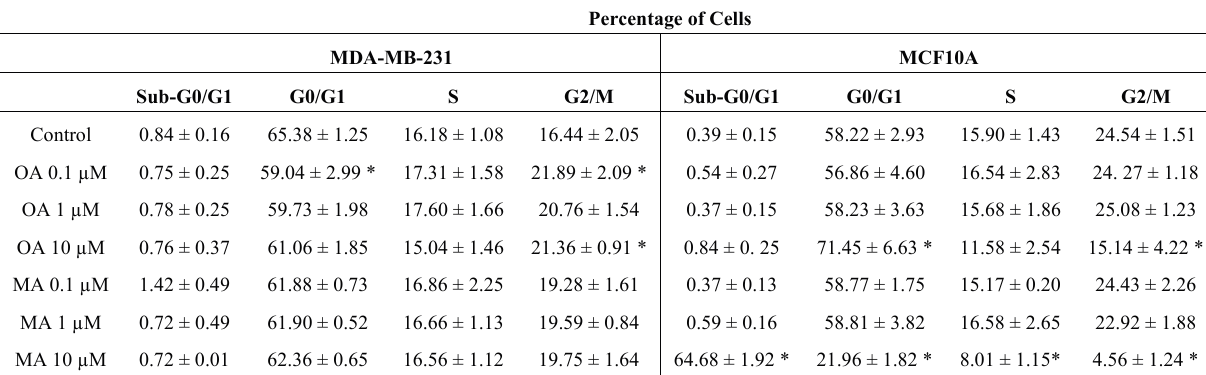
Table 1. Distribution of cells in phases of the cell cycle for MDA-MB-231 and MCF10A cells treated with OA and MA at 0.1 µM, 1 µM, and 10 µM at 24 h. Values represent the mean ± SEM of three independent experiments. Statistically significant differences are represented by (*) at p < 0.05 with respect to the untreated